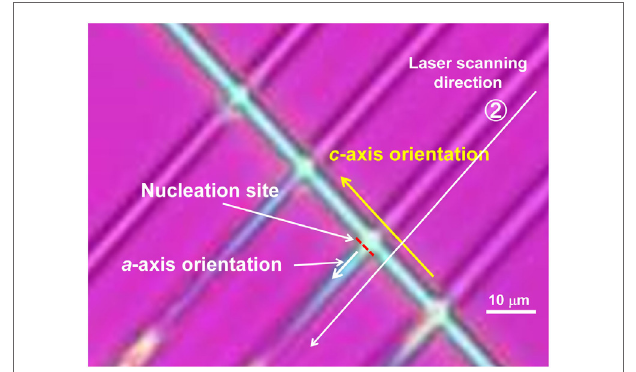
FigUre 9 | schematic illustration for the nucleation and crystal growth in the second line after crossing .